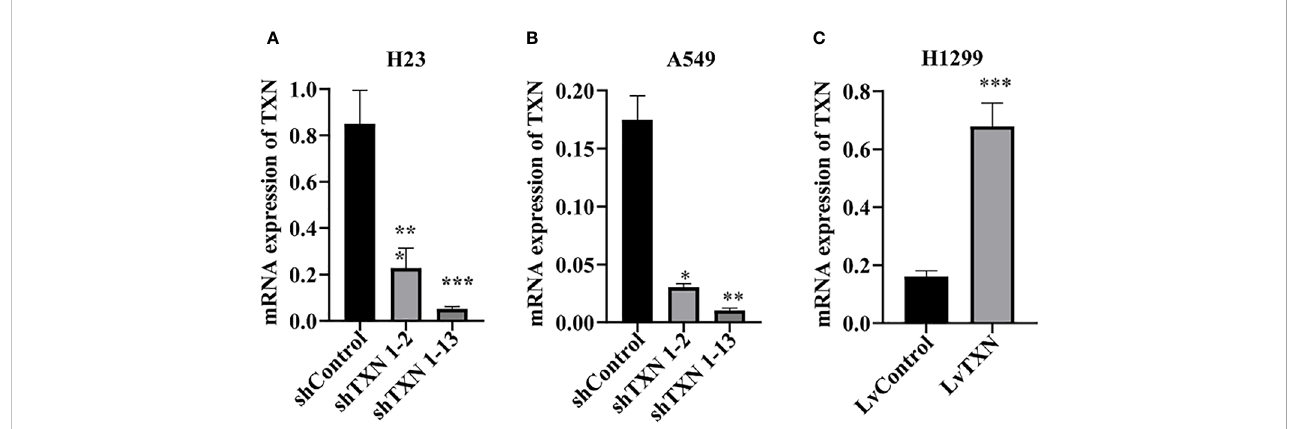
FIGURE 12 RT-qRCR veri fi cation of lentiviral TXN knockdown and overexpression. (A) mRAN expression of TXN after knockdown in H23; (B) mRAN expression of TXN after knockdown in A549; (C) mRAN expression of TXN after overexpression in H1299. *p < 0.05, **p < 0.01,***p <